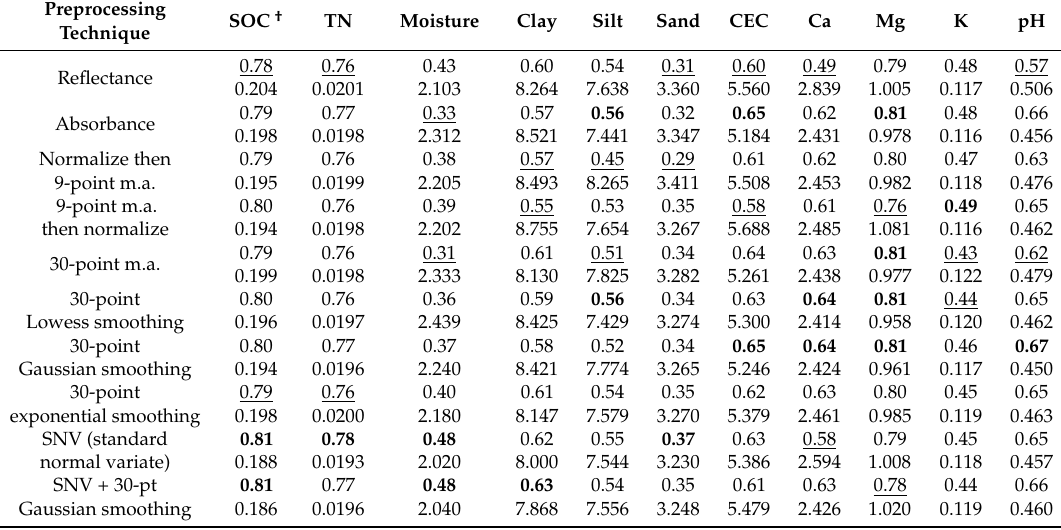
Table 3. Fit statistics for soil property estimation with each preprocessing technique, calculated with partial least squares regression (PLSR) and cross-validation on the combined dataset including depth, EC a , CI, and spectra (DECS). For each cell, the top row is R 2 and the bottom row is root mean square error (RMSE; see Table 1 for units). Bold entries denote the highest R 2 for each soil property, while underlined entries are the two lowest for each